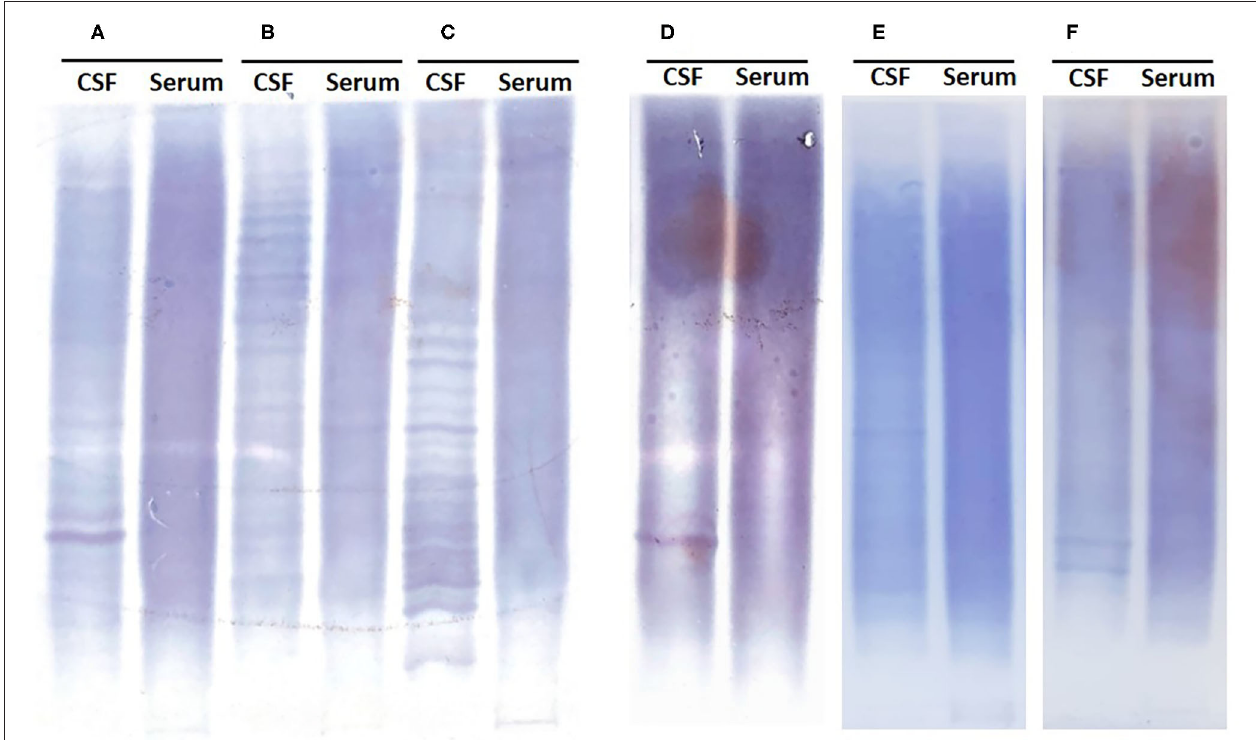
FIGURE 5 | Representative high-resolution electrophoresis reflecting the difficulty on reporting OCB results in specific cases. (A–C) Easily identifiable bands in CSF not present in the serum sample. (D) Guillain–Barré syndrome with a K-Index of 39.98, one easy to distinguish and possibly a second OCB, making it difficult to report the OCB status. (E) MS with a K-Index of 39.29, faint bands on CSF impossible to confirm on serum due to strong background, reported negative OCB. (F) Recurrent left optic neuritis without MS, with K-FLC levels < 0.03 and two reported OCB. OCB, oligoclonal band; CSF, cerebrospinal fluid; K-Index, kappa index; MS, multiple sclerosis; K-FLC, kappa free light